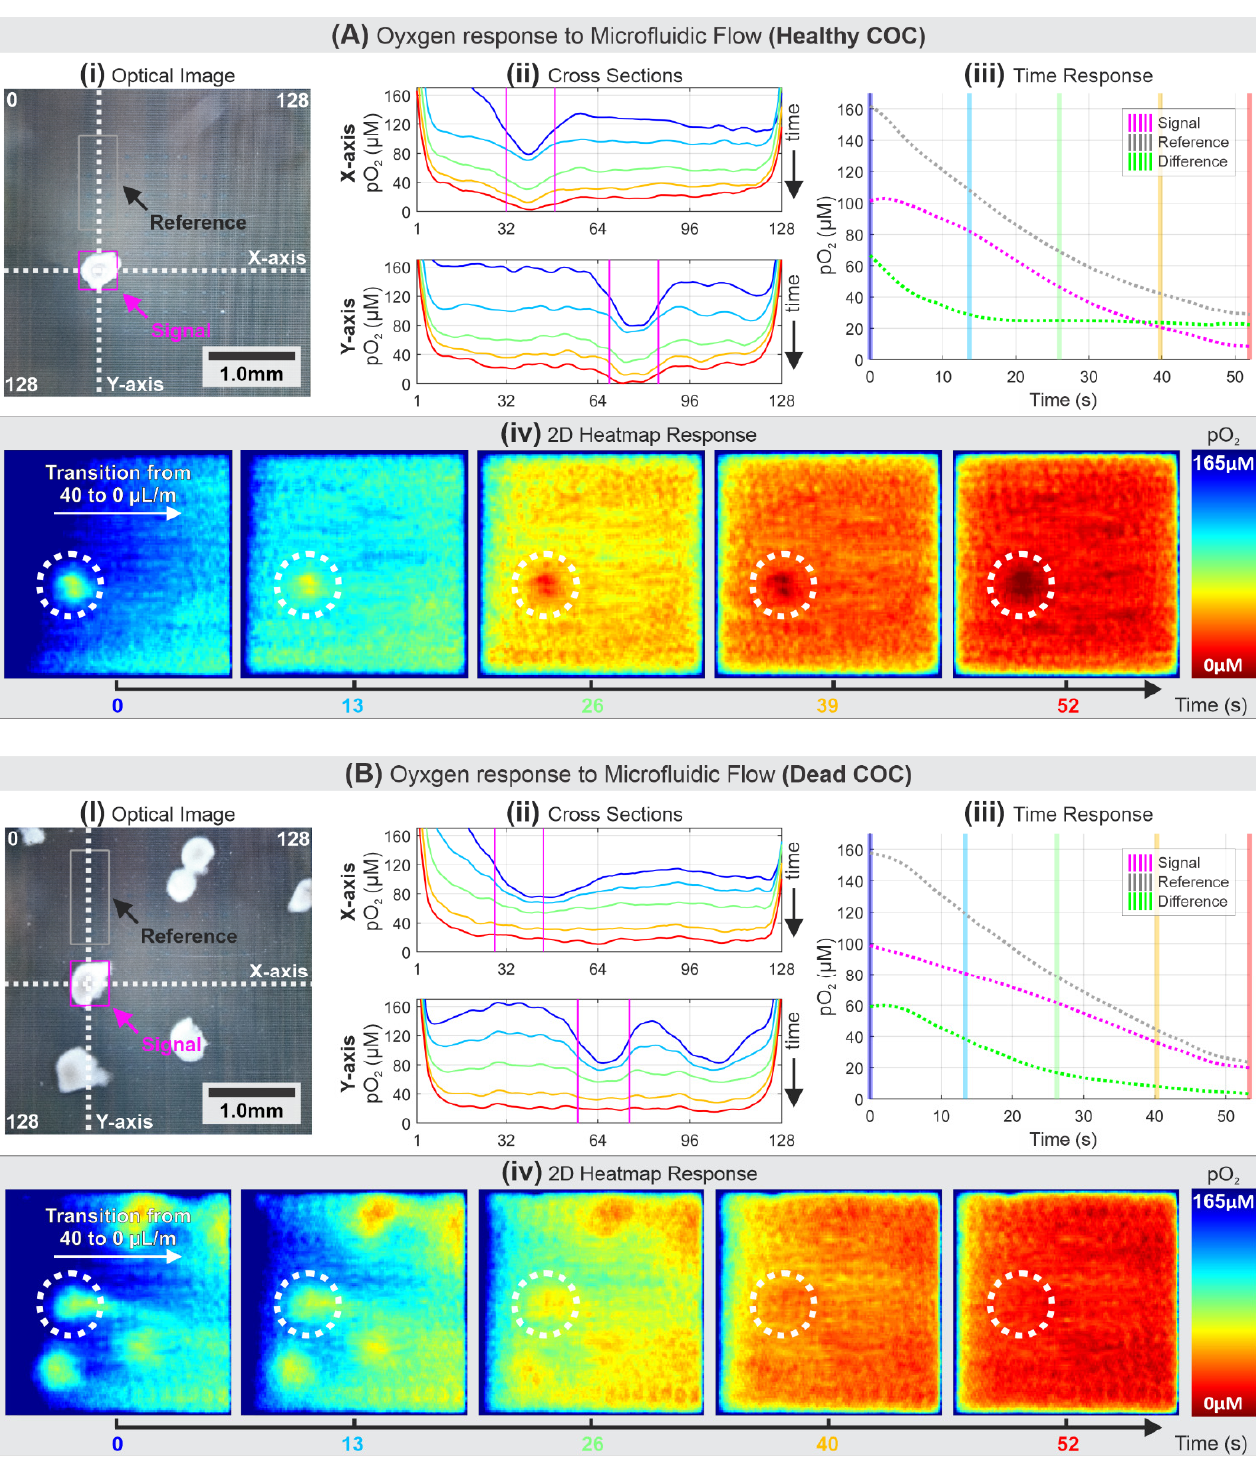
Figure 6. pO 2 imaging after a transition from 40 µL/min to 0 µL/min microfluidic flow with ( A ) a healthy COC and ( B ) dead COCs. The white dotted circles compare the pO 2 imaging response between the healthy and dead COC.